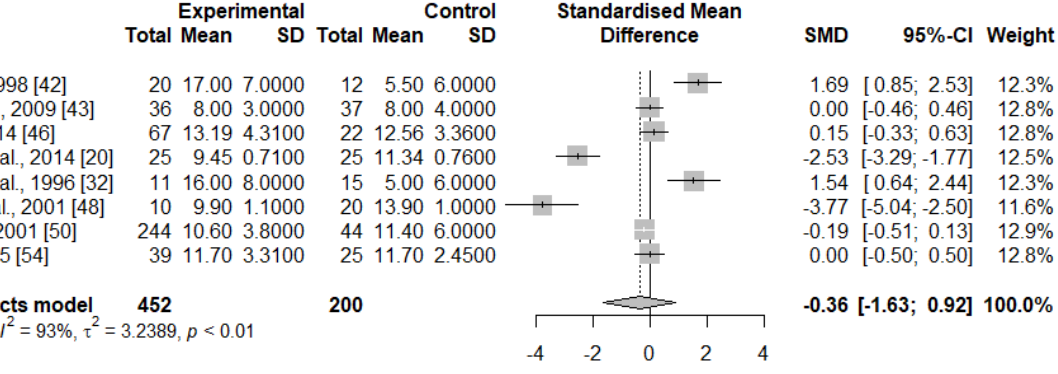
Figure 2. Random-effect meta-analysis for the levels of B cells in IRPL and HC women.